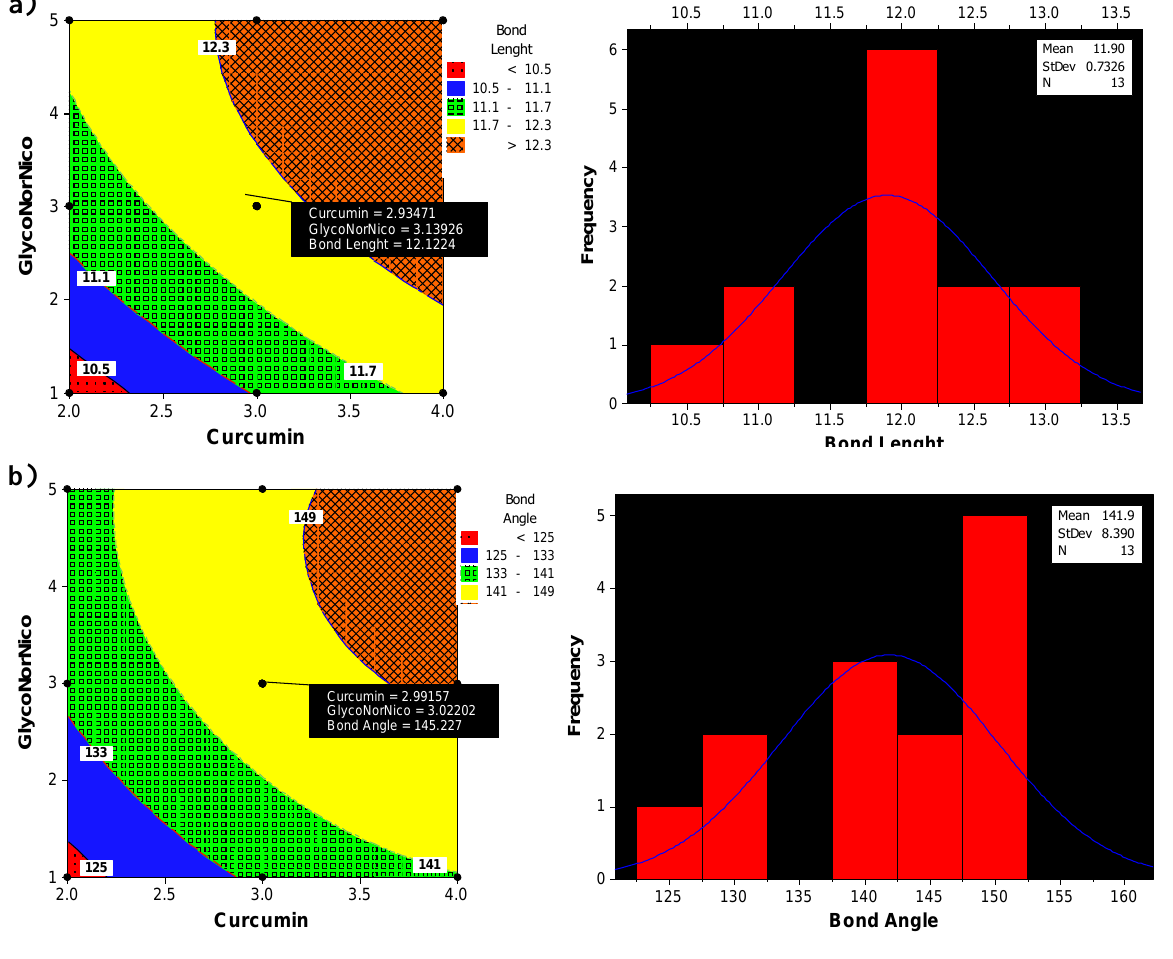
Figure 11. Corresponding Contour Plots of ( a ) bond length, ( b ) bond angle and ( c ) VdW vs . Curcumin and Glyconornicotine. The histograms show the frequency distribution of the 13 runs with respect to normality from the optimized